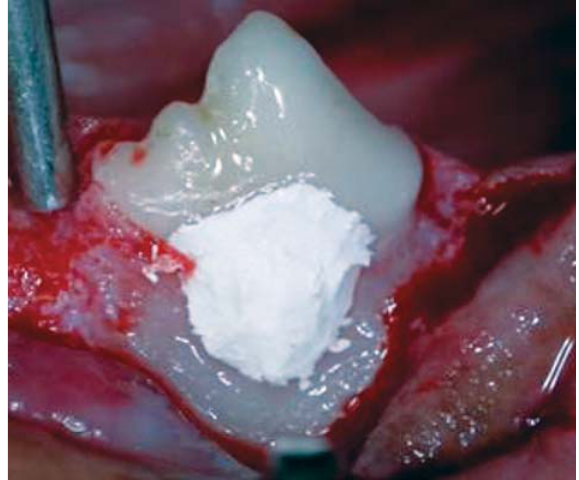
Figure 2- (cid:2)(cid:3)(cid:4)(cid:5)(cid:6)(cid:5)(cid:7)(cid:8)(cid:4)(cid:2)(cid:8)(cid:9)(cid:10)(cid:11)(cid:7)(cid:12)(cid:2)(cid:13)(cid:14)(cid:2)(cid:3)(cid:4)(cid:8)(cid:9)(cid:9)(cid:2)(cid:15)(cid:15)(cid:2)(cid:14)(cid:16)(cid:17)(cid:7)(cid:8)(cid:12)(cid:5)(cid:13)(cid:6)(cid:2)(cid:18)(cid:11)(cid:14)(cid:11)(cid:7)(cid:12)(cid:2)(cid:19)(cid:4)(cid:4)(cid:11)(cid:18)(cid:2) with